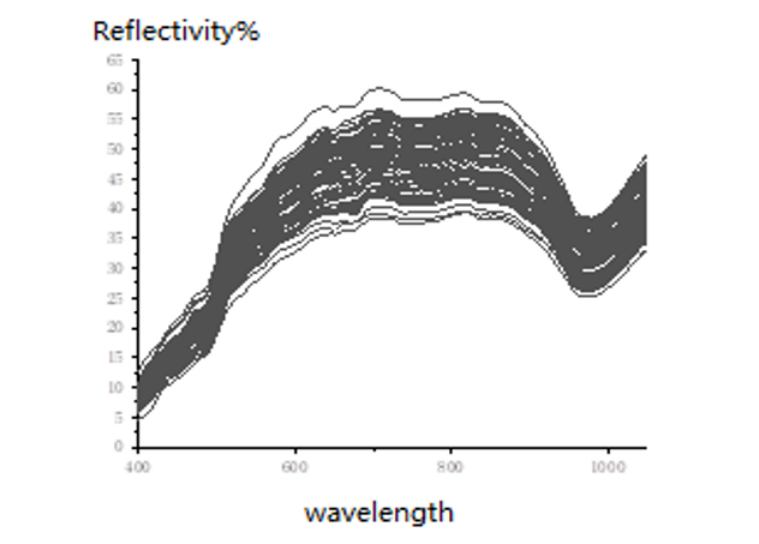
Fig. 3. Spectral image preprocessed by SNV